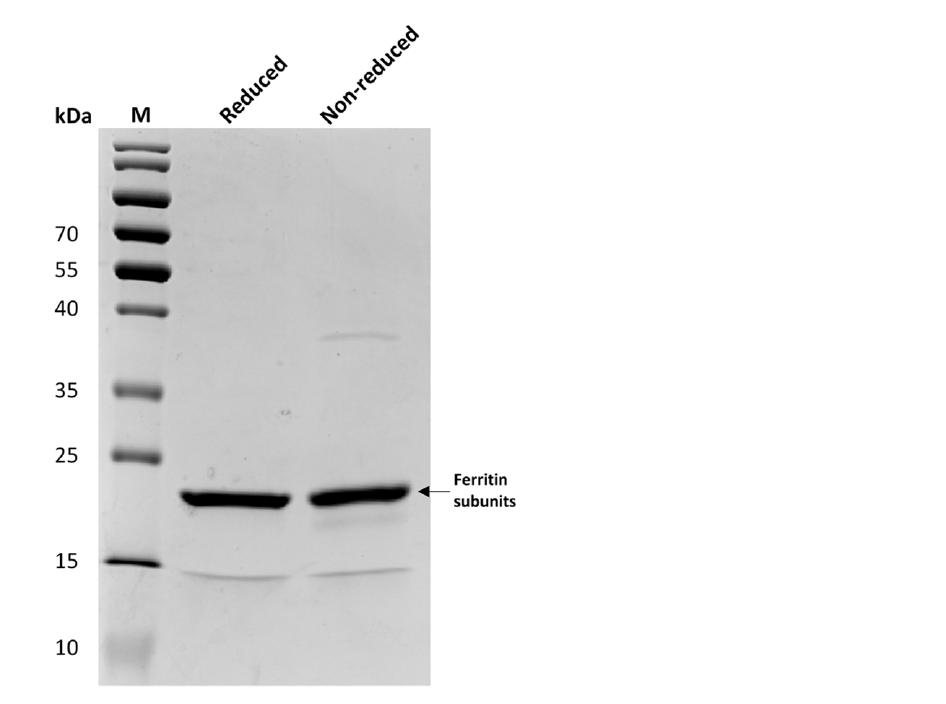
Figure 2. The antigen protein of SF was analyzed by SDS-PAGE. SDS-PAGE was performed under reduced (lane Reduced) and non-reduced (lane Non-reduced) conditions to indicate the size and distribution of SF subunits. The protein size standard (lane M) with its molecular mass (kDa) is shown on the left side.